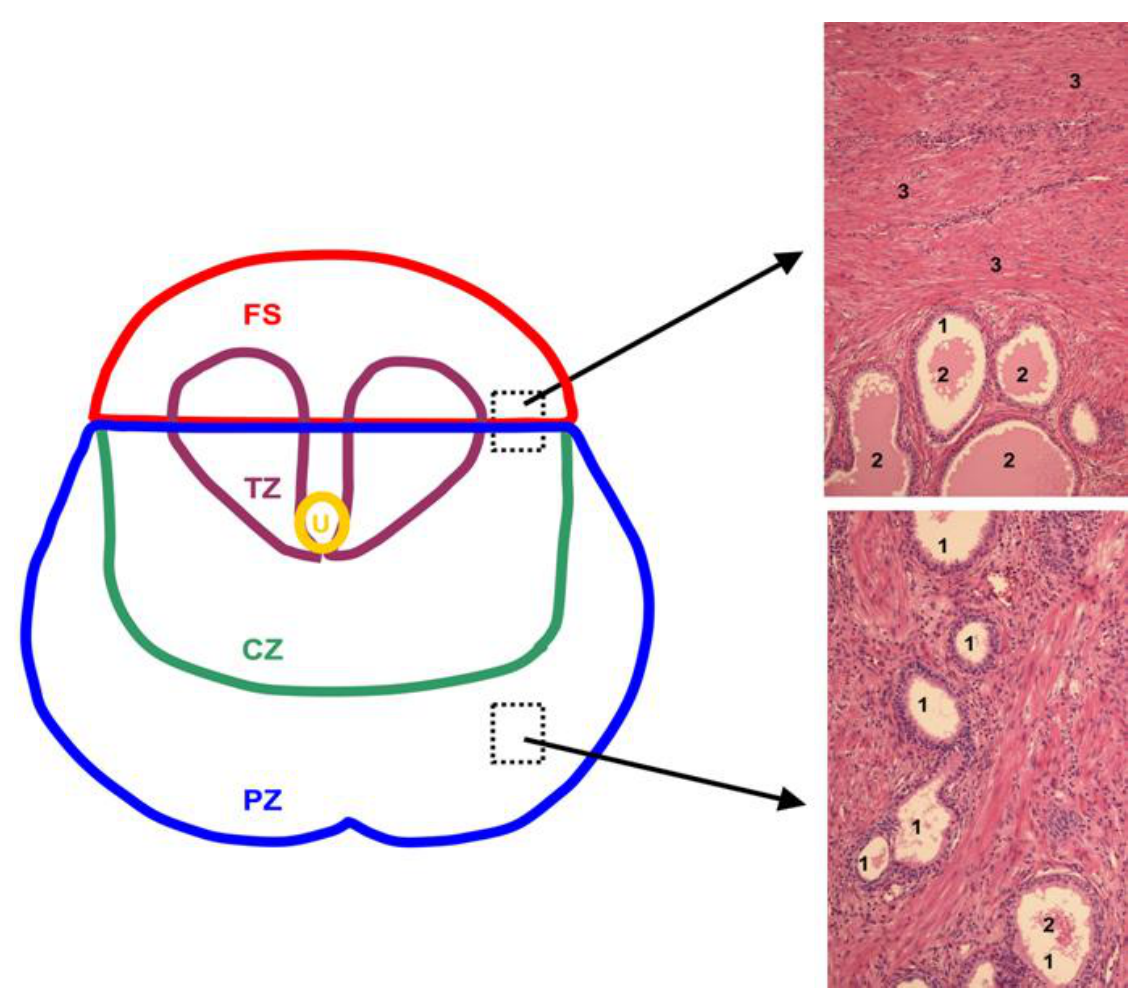
FIGURE 1. Zones in the human prostate (FS = fibromuscular stroma, TZ = transition zone, U = urethra, CZ = central zone, PZ = peripheral zone) with two 100  magnifications showing glandular and stromal parts of human prostate (1 = secretory parts of prostate gland, 2 = prostate secretions in the secretory parts, 3 = stroma, mainly consisting of smooth muscle cells and connective tissue). Stromal tissue comprises 30% of the prostate. The glandular parts consist of pluripotent stem cells; basal epithelial cells residing in the basal compartment of the epithelial layer and expressing CK5 and CK14; transit amplifying cells in the basal layer, which form an intermediate cell type between undifferentiated stem cells and fully differentiated secretory cells; neuroendocrine cells that regulate growth, differentiation, and the secretory activity of the epithelium via paracrine secretion of hormones; and terminally differentiated luminal secretory cells, clustered in acini and morphologically characterized by abundant secretory granules and enzymes[6,7]. Acini drain into a system of branching epithelial ducts and tubules that end up directly in the urethra. The nonglandular part or stroma is composed of smooth muscle cells, fibroblasts, connective tissue, and blood vessels. This part is highly innervated, mainly by adrenergic